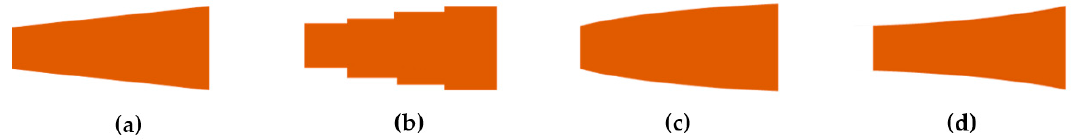
Figure 3. Schematic of the ( a ) linear; ( b ) multi-sectional; ( c ) parabolic; and ( d ) exponential Si inverse tapers (top view).